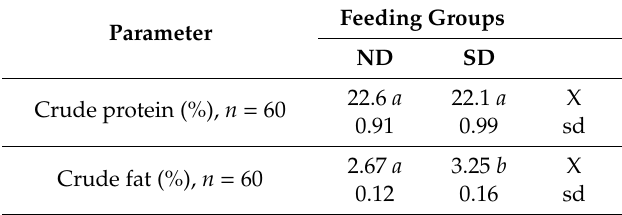
Table 2. Basic chemical and physicochemical parameters of experimental raw